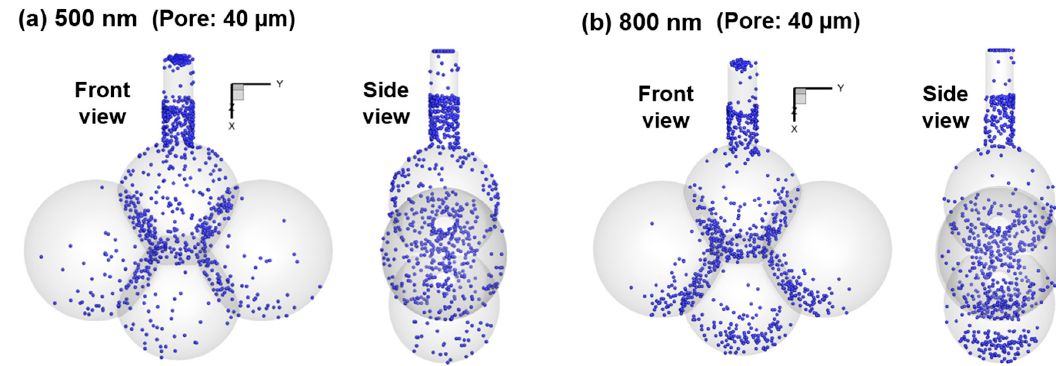
Figure 10. of surface deposition in the 40-µm-pore model for large nanoparticles: ( a ) 500 nm, and ( b ) 800 nm. 800 nm.